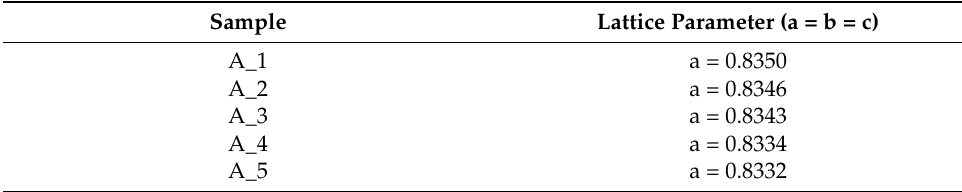
Table 3. Lattice parameter of the samples A_1 (600 ◦ C for 48 h), A_2 (800 ◦ C for 48 h), A_3 (1000 ◦ C